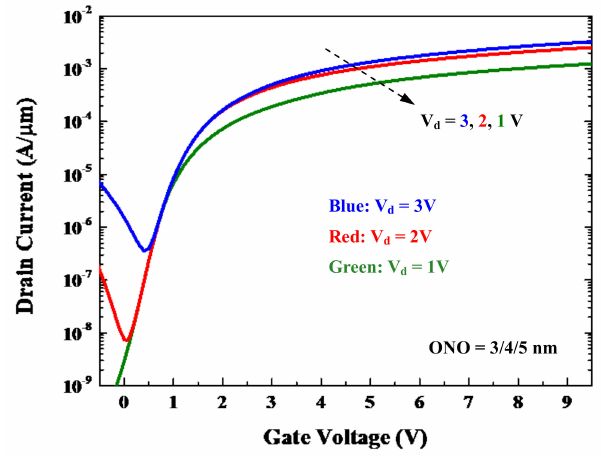
Figure 7. Numerical results of drain currents in scaled double-gate Schottky barrier charge-trapping cells as a function of gate voltage at drain voltages from 1 to 3